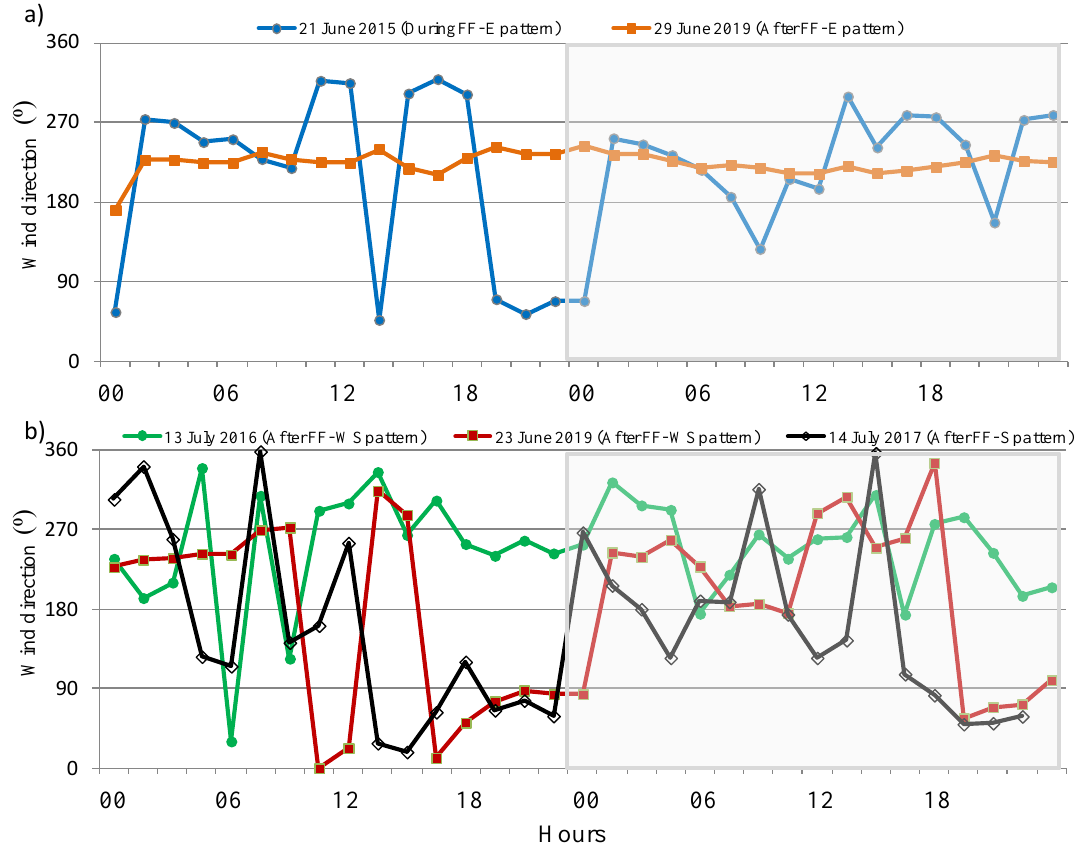
Figure 6. Variation of wind direction in the city of Cordoba during the selected episode days. Graphs show wind direction data every 90 min during 48 h, corresponding to the day before and the episode day, under different patterns: ( a ) E pattern (21 June 2015 and 29 June 2019); ( b ) WS pattern (13 July 2016 and 23 June 2019); S pattern (14 July 2017). The grey box indicates the episode day.